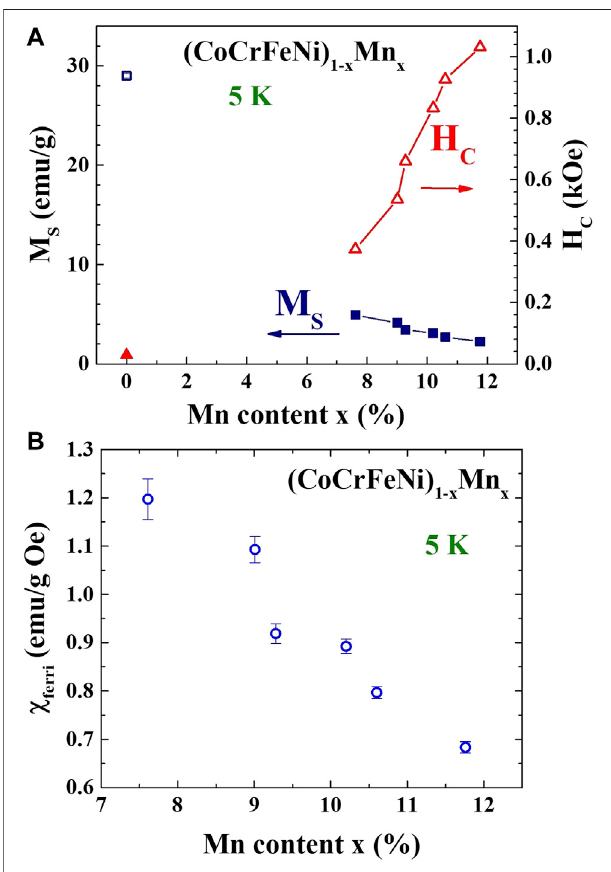
FIGURE 6 | Variations of (A) the saturation magnetization and coercivity fi elds, and (B) the ferrimagnetic susceptibility at 5 K with Mn content x .